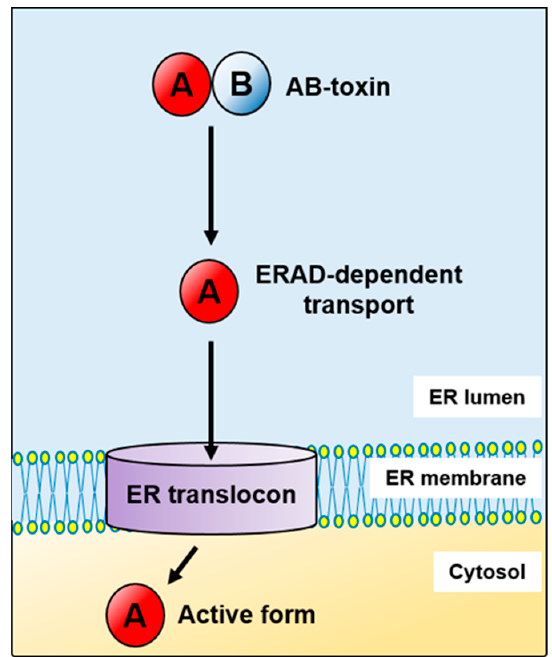
Figure 1. AB-toxins subvert the endoplasmic reticulum-associated protein degradation pathway (ERAD) in their transport from the ER to the cytosol.